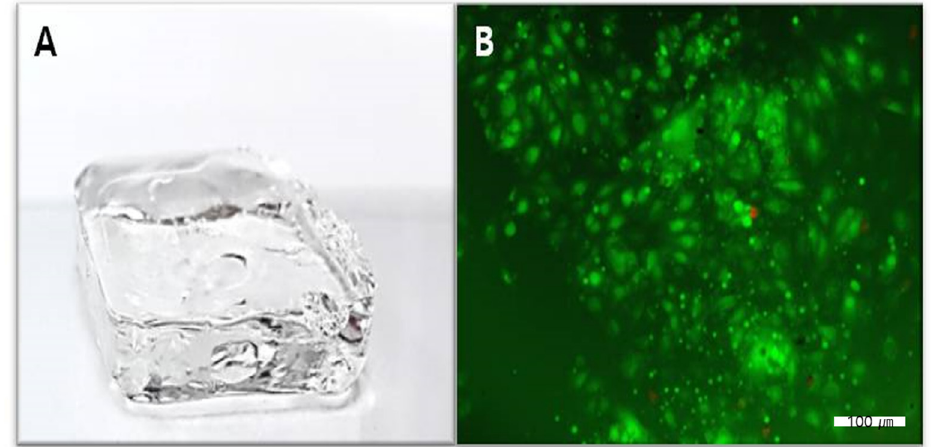
Figure 8. ( A ) Pulp cells in HA-collagen hydrogel ( B ) Live and dead analysis image shows that dental pulp cells adhered well to the HA-collagen hydrogel, proliferated progressively, and maintained cell viability with green fluorescence. HA, hyaluronic acid.